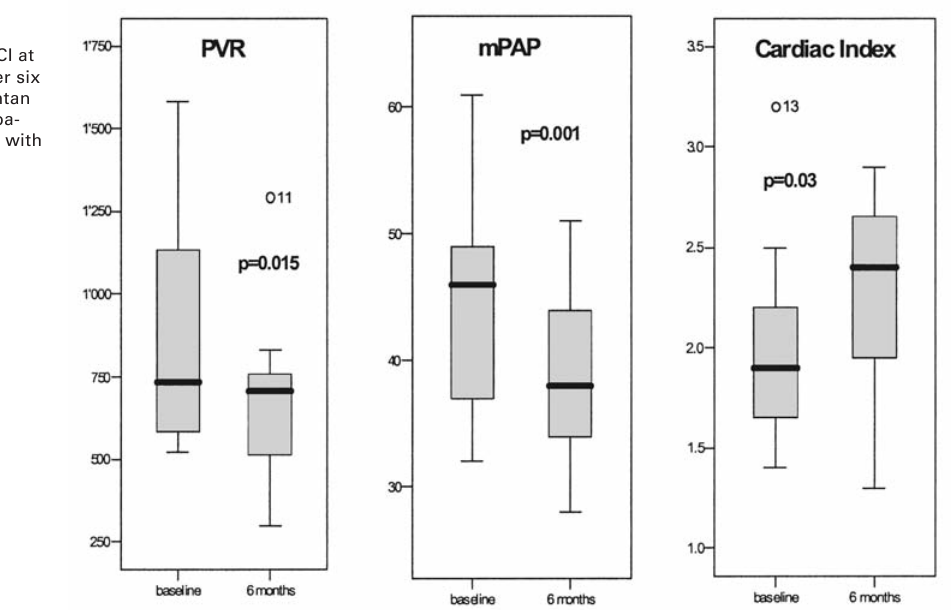
Figure 1 PVR, mPAP and CI at baseline and after six months of Bosentan treatment in 15 pa- tients diagnosed with CTEPH.